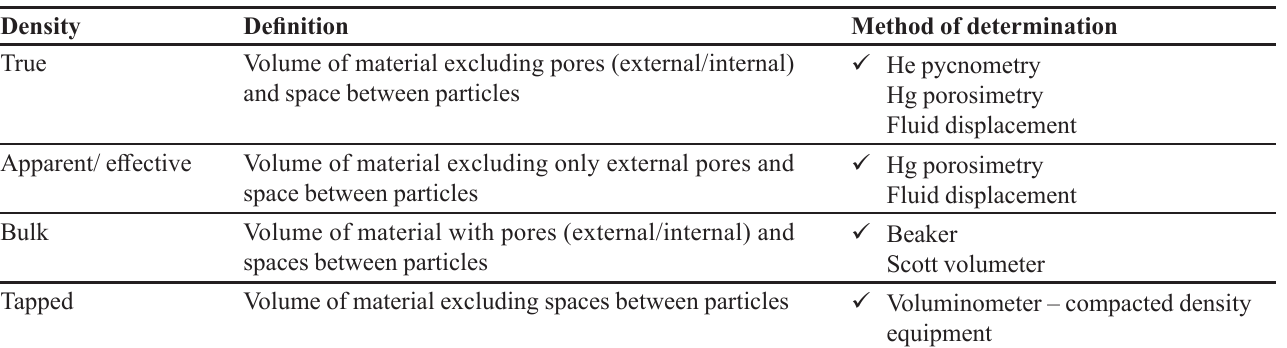
TABLE V - Types of densities used in the evaluation of multiparticulate systems (Lowell et al ., 2004; Santos et al ., 2006)